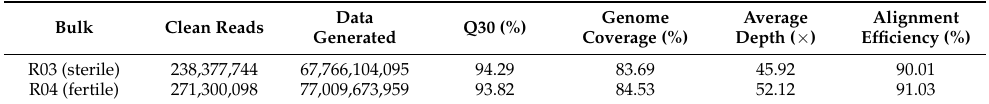
Table 2. Candidate genomic regions identified by association analysis of BSA-seq.